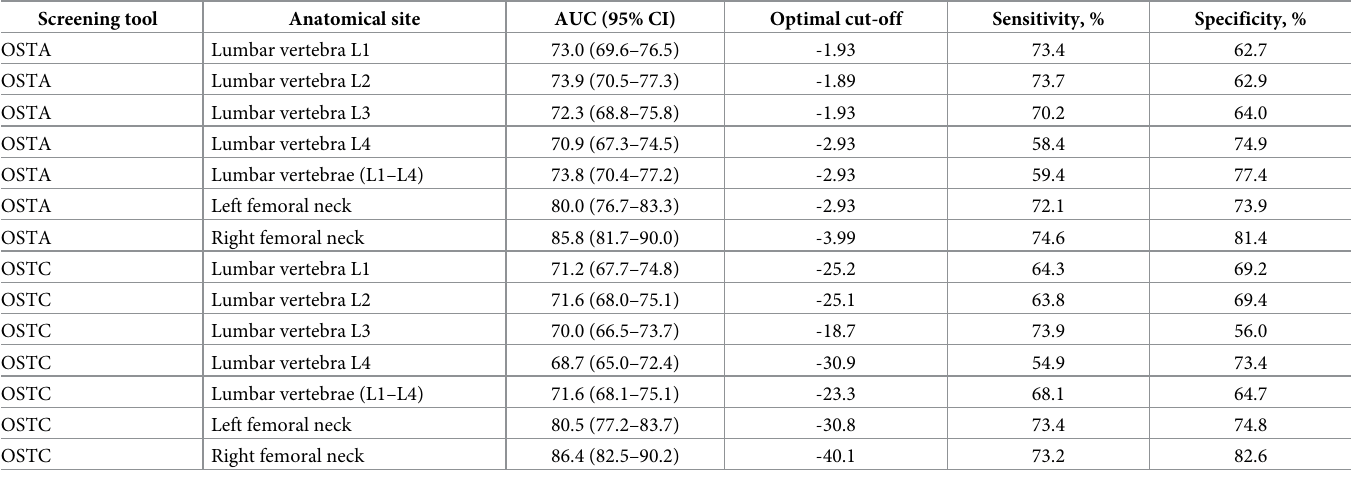
AUC: Area under the curve; OSTA: Osteoporosis self-assessment tool for Asians; OSTC: Osteoporosis screening tool for Chinese. The optimal cut-off points were determined based on Youden’s